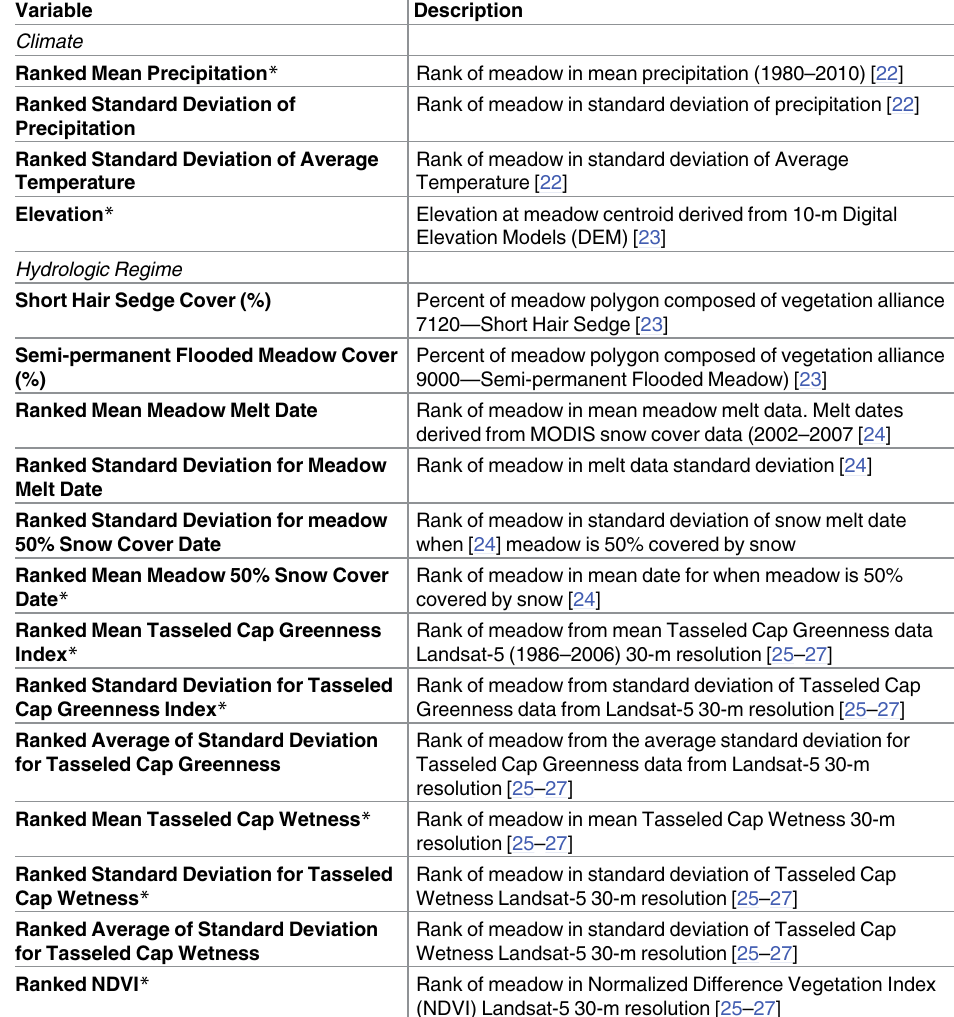
Table 1. Twenty-seven geospatial, hydro-climatic, and vegetation variables derived from remote sensing used for multivariate matching of non-stock meadows to selected stock meadows in Yosem- ite (YOSE) and Sequoia (SEKI) National